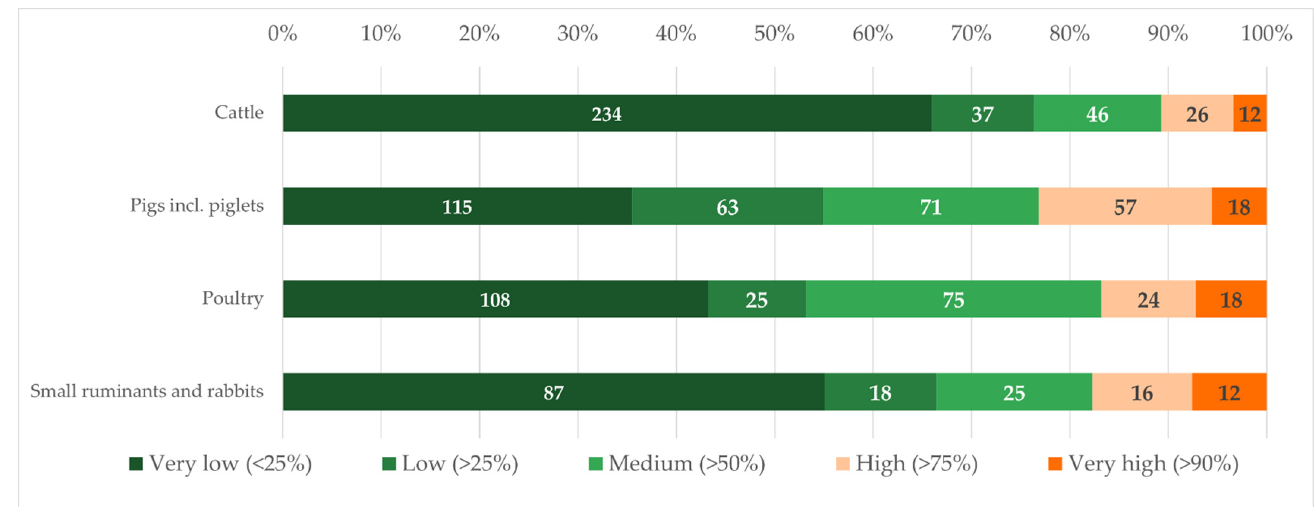
Figure 1. Quantitative metaphylaxis use per species in absolute numbers (inside the bars) and in per cent (x-axis) based on n = 1087 survey responses to Q6 (multiple answers possible, all species-specific responses merged) in six categories: Very low (<25%), Low (>25%), Medium (>50%), High (>75%), Very high (>90%).